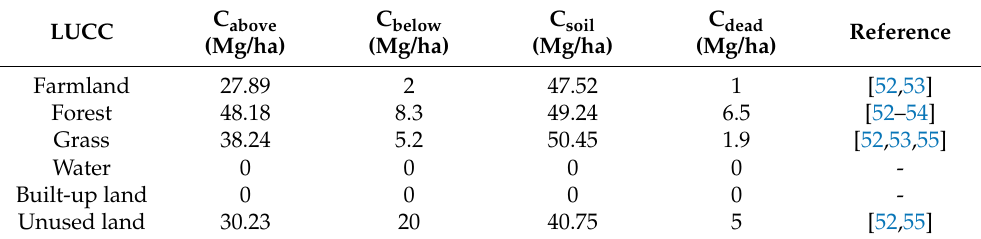
Table 5. Carbon density in different carbon pool on diverse LUCC and their references.